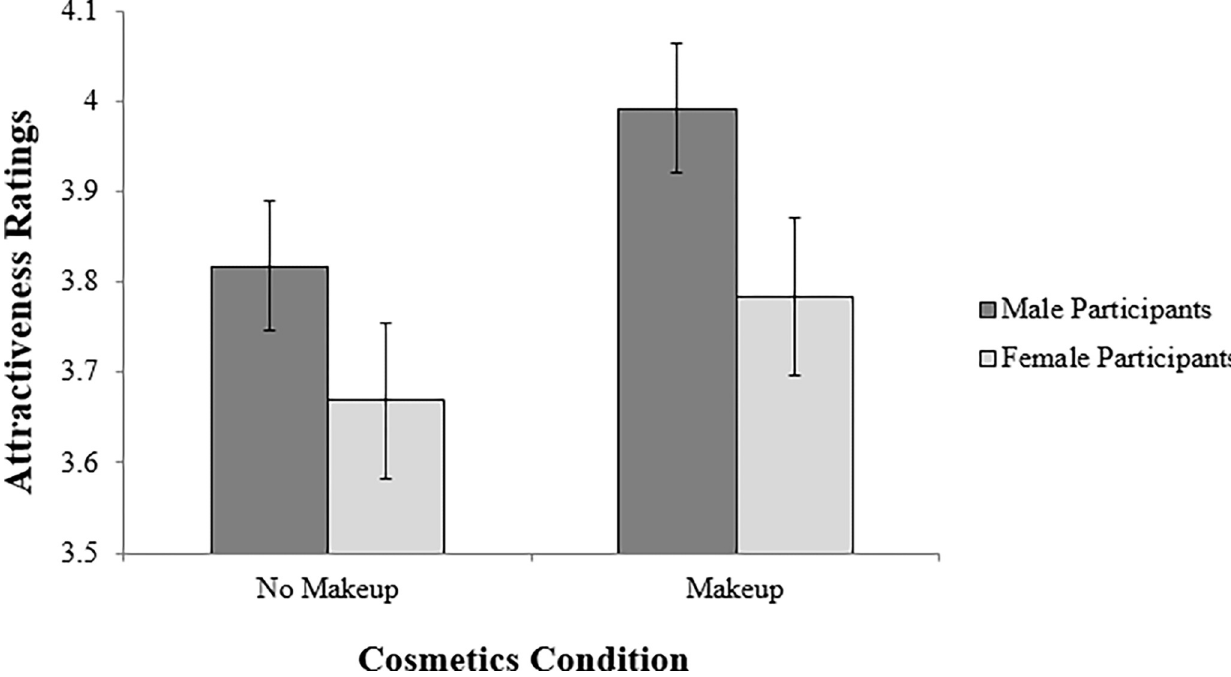
Fig 2. Ratings of attractiveness depending on makeup condition. Comparison of attractiveness ratings for male faces with no cosmetics and with subtle cosmetics applied by a professional makeup artist. Error bars indicate the standard error of the mean.